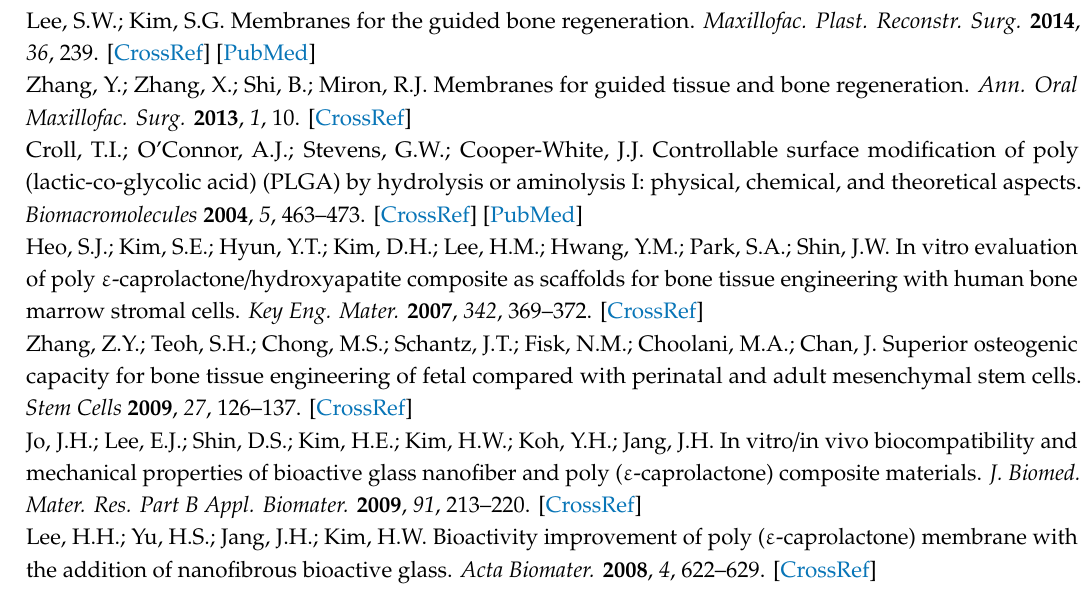
Figure 10. Effects of SrHANF on bone mineralization in MG63 osteoblast-like cells. ( a ) Optical images and ( b ) quantification of mineral deposition by ARS staining after 21 and 28 days of incubation. (1) PCL, (2) PCL–SrHANF (65), (3) PCL–SrHANF (130), and (4) PCL–SrHANF (195). The data represent the mean ± SD, n = 3. Different letters represent significance at p < 0.05.